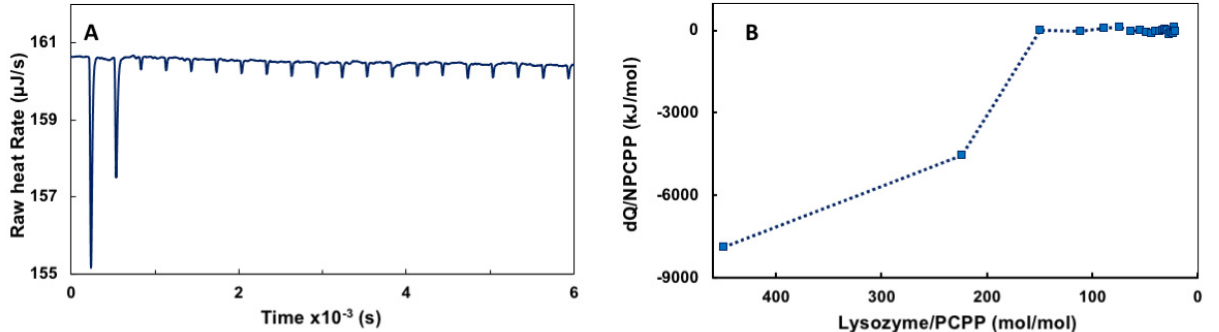
Figure A2. ITC data for the binding of lysozyme onto PCPP (reverse titration): ( A ) raw data and ( B ) ITC isotherm (0.125 mg/mL lysozyme solutions were titrated with 2.5 mg/mL solutions of PCPP, PBS, pH 7.4).